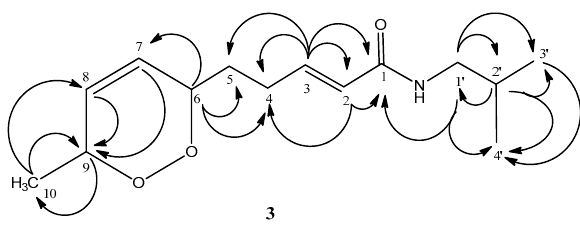
Figure 2. Key HMBC correlations for compound 3 .